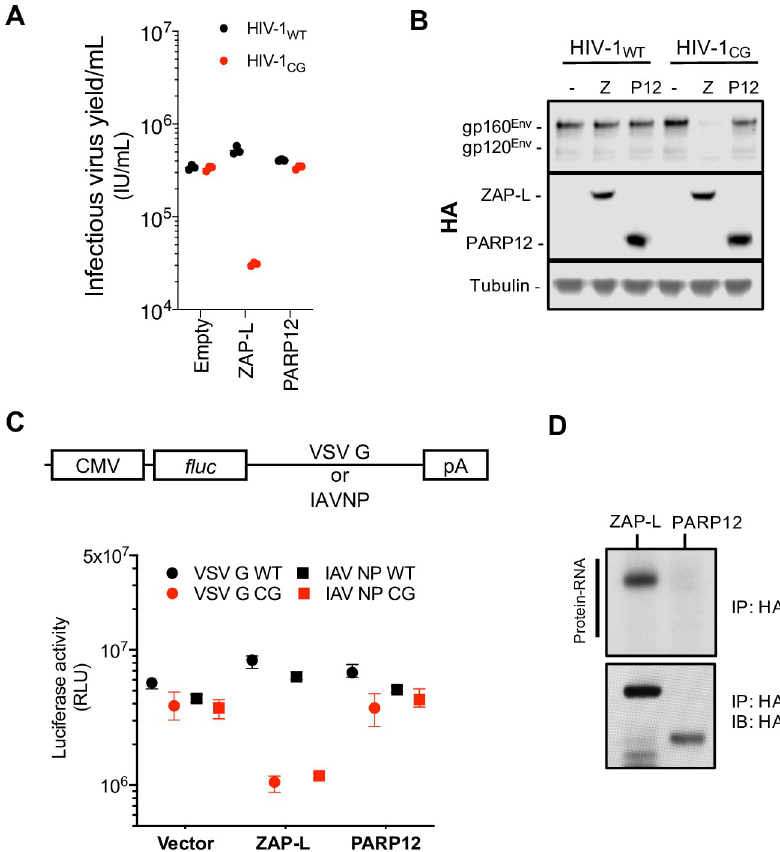
Fig 2. Human PARP12 does not restrict CG-rich viruses. (A-B) HEK293T ZAP -/- cells were transfected with HIV- 1 WT or HIV-1 CG plasmids and plasmids encoding human ZAP-L-HA or PARP12-HA. Supernatant was harvested after 48h and the infectious virus yield was determined using MT4-R5-GFP target cells (A). Whole cell lysates were analysed by western blotting (B). IU, infectious units. (C) HEK293T ZAP -/- cells were transfected with plasmids encoding a luciferase reporter gene that contained VSV-G wildtype (WT) or CG-enriched (VSV-G CG) sequences, or IAV-NP WT or CG-enriched sequences as 3’ UTRs, together with plasmids expressing ZAP-L, PARP12 or an empty plasmid (vector). RLU, relative light units. (D) HEK293T ZAP -/- cells were transfected with plasmids expressing ZAP-L-3xHA or PARP12-3xHA and 24h later culture medium was supplemented with 100 μ M 4SU. After overnight incubation cells were irradiated with UV light, and ZAP-L/PARP12 were immunoprecipitated. RNA bound to each protein was radiolabeled and protein-RNA adducts were resolved by SDS-PAGE, transferred to a nitrocellulose membrane and exposed to autoradiographic film. In parallel, a western blot of immunoprecipitated proteins was done using anti-HA antibody. IP, immunoprecipitation. IB,